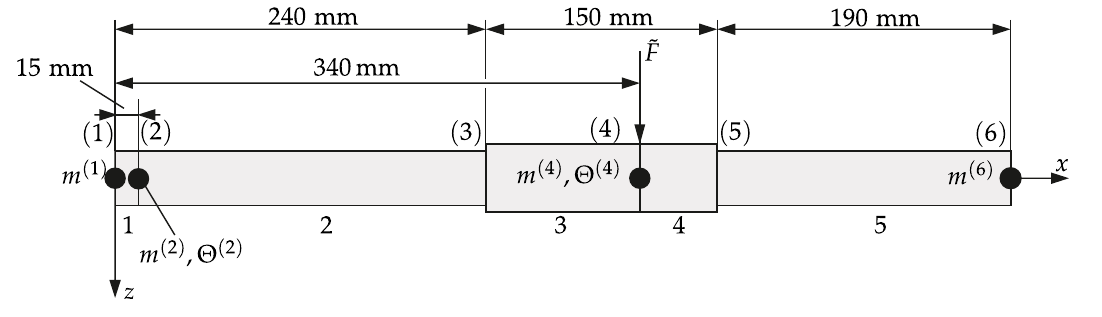
Figure 4. Model of the numerical example.